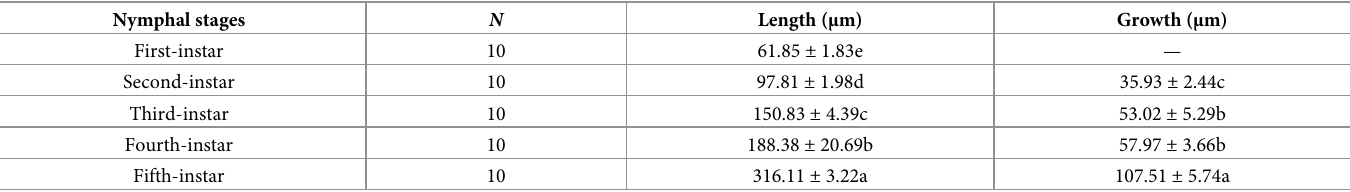
Table 1. Length and growth (mean ± SE) of the five nymphal stages of Diaphorina citri antennae. Nymphal